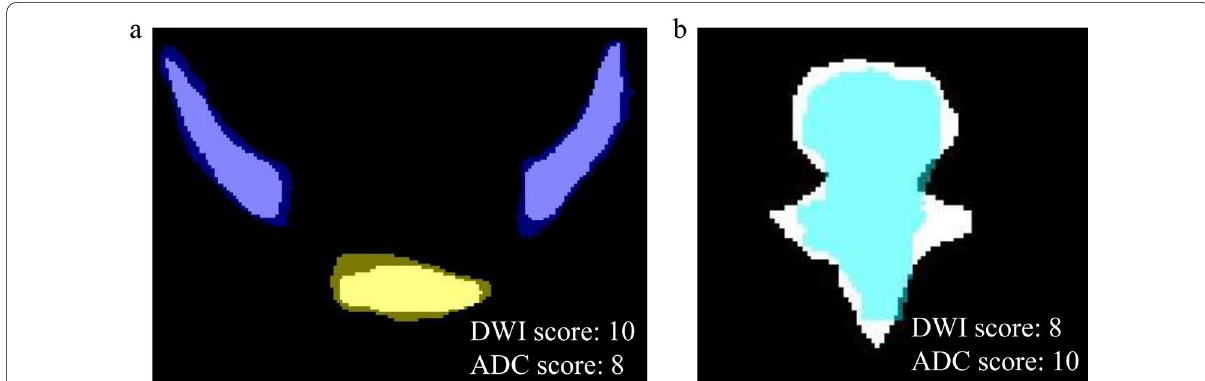
Fig. 7 SCORE results on DWI and ADC images. a The range of the CNN-predicted segmentations of sacrococcyx (yellow label) and ilium (deep blue label) was slightly more extensive than the manual segmentations (white background), attaining DSC values of 0.92 and 0.88, respectively. According to the SCORE system, 10 on the DWI image and 8 on the ADC image were obtained. b The range of the CNN-predicted segmentation of lumbar vertebra (light blue label) was slightly smaller than manual segmentation (white background) with a DSC value of 0.82. According to the SCORE system, 8 on the DWI image and 10 on the ADC image were obtained